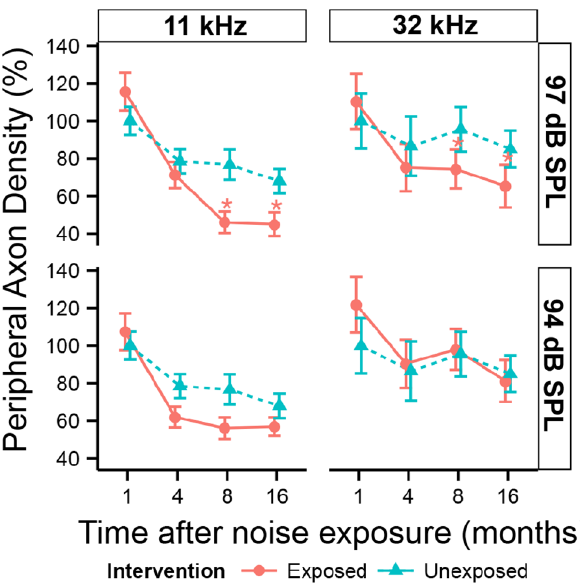
exposure to neuropathic (97 dB SPL) or non-neuropathic (94 dB SPL) noise. Data are group means ( ± SD), expressed relative to data from the youngest unexposed ears. Statistical significance of the group differences is indicated by asterisks: * : p < 0 . 05 , ** : p < 0 . 01 . N = 3 – 7 animals per time and noise